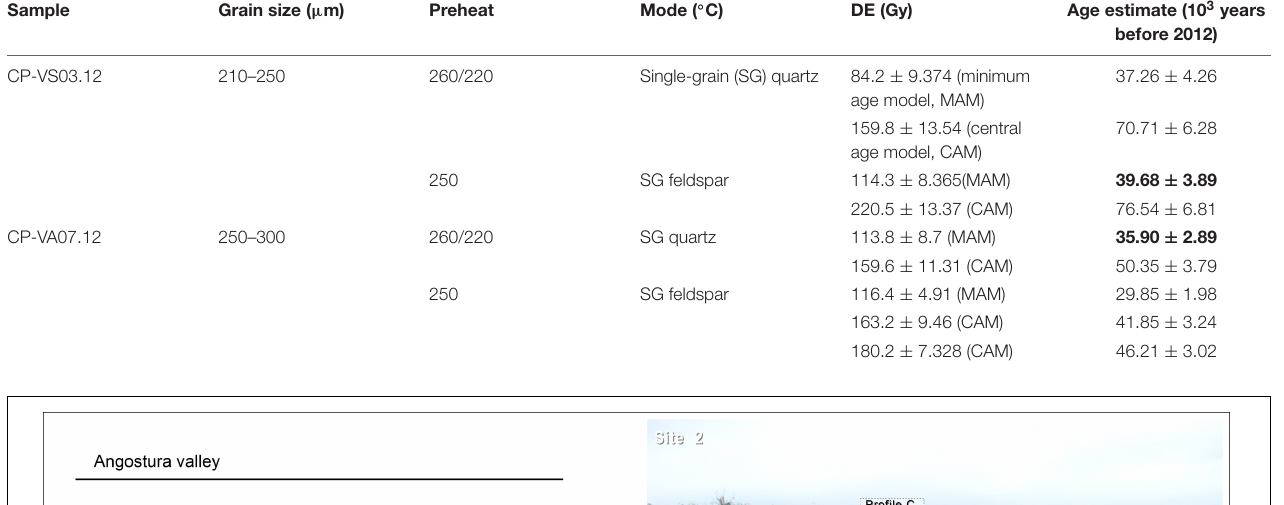
TABLE 2 | Single-grain equivalent dose (DE) and estimated ages for the sand samples (preferred age in bold). Sample Grain size ( µ m) Preheat Mode ( ◦ C) DE (Gy) Age estimate (10 3 years CP-VS03.12